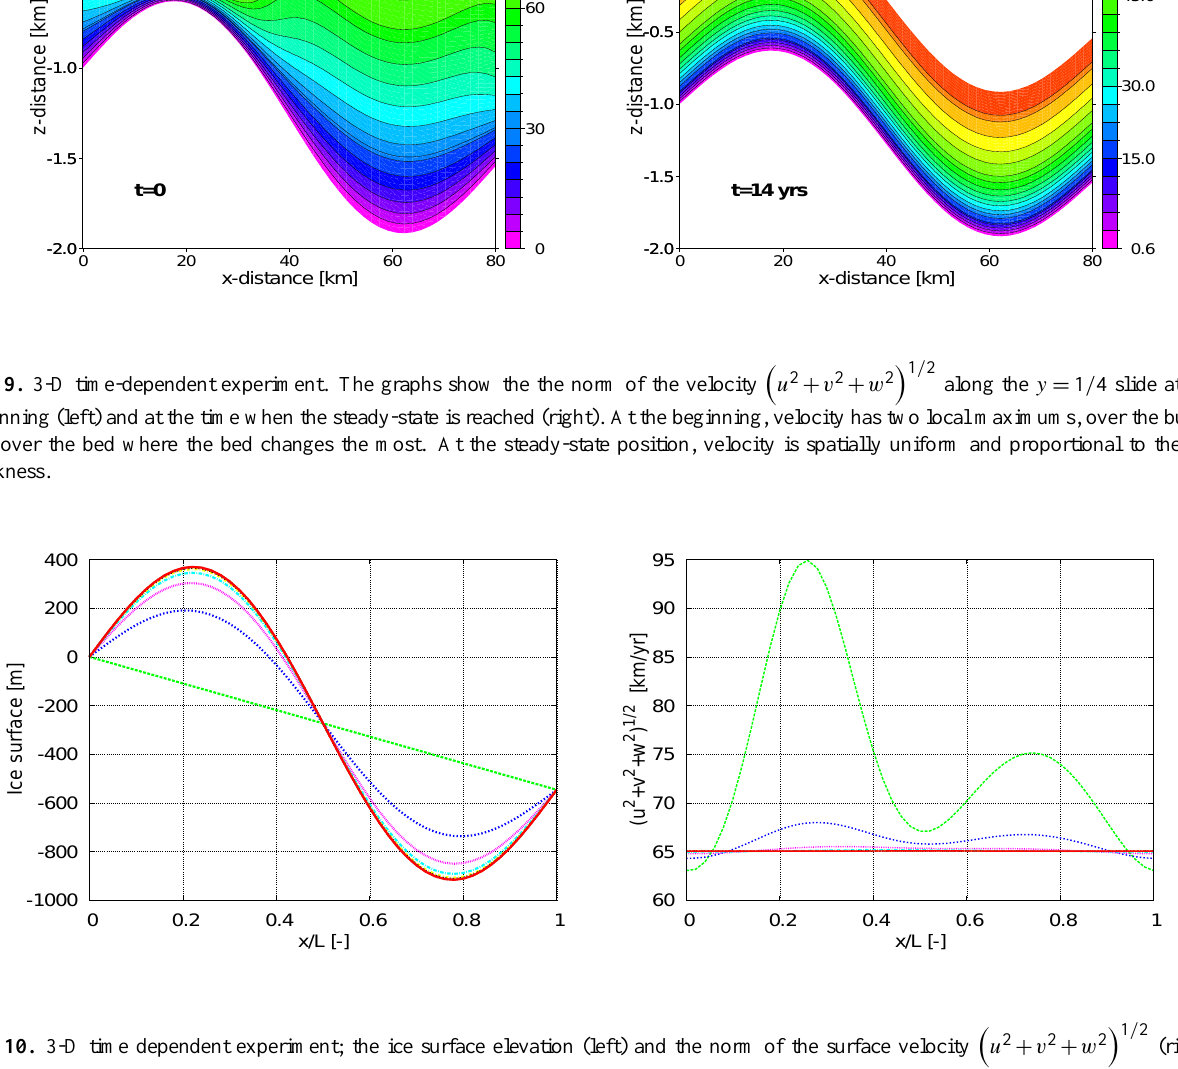
Fig. 10. 3-D time dependent experiment; the ice surface elevation (left) and the norm of the surface velocity change along y = 1 / 4 slide. Ice surface and the norm of the surface velocity are shown every 1.5 years over the 14-year period, green curves are the initial values and red curves are the final values. At the beginning, velocity has two local maximums, over the bump and over the bed where the bed changes the most. At the steady-state position, the norm of the surface velocity is spatially